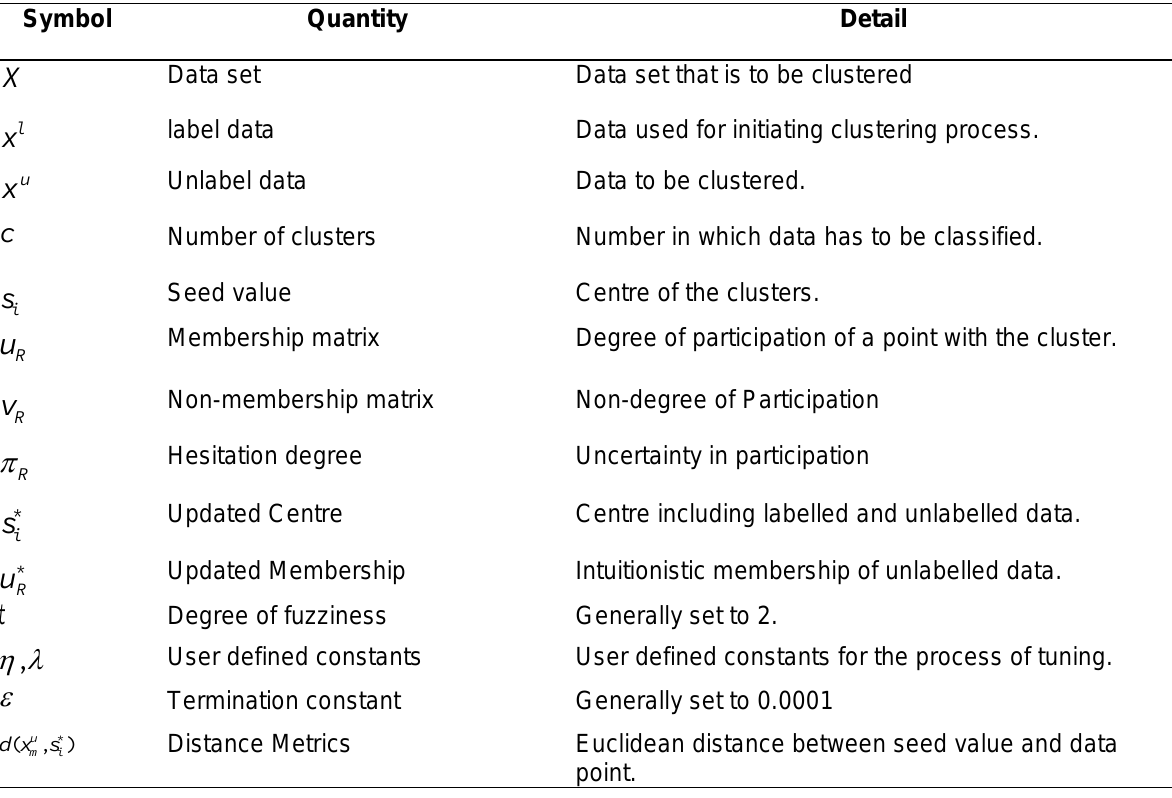
Table 1. Conventional Symbols used i n the Proposed